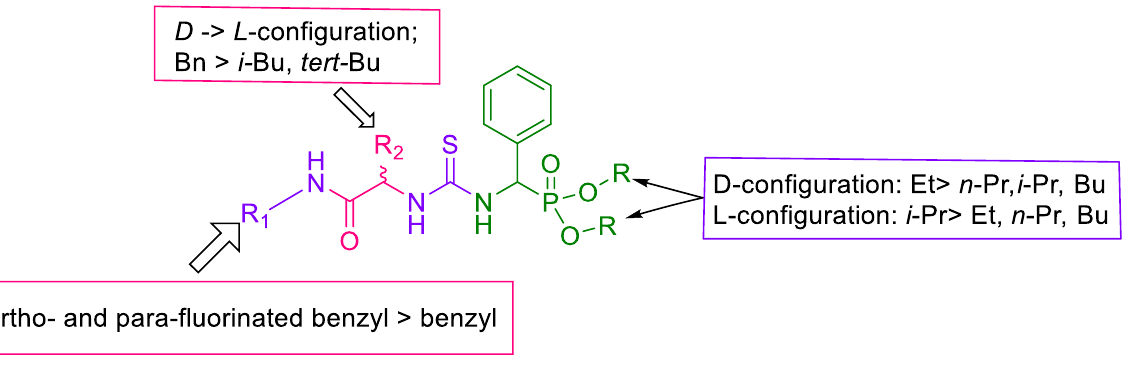
Figure 105. Phosphonate thioureas containing amino